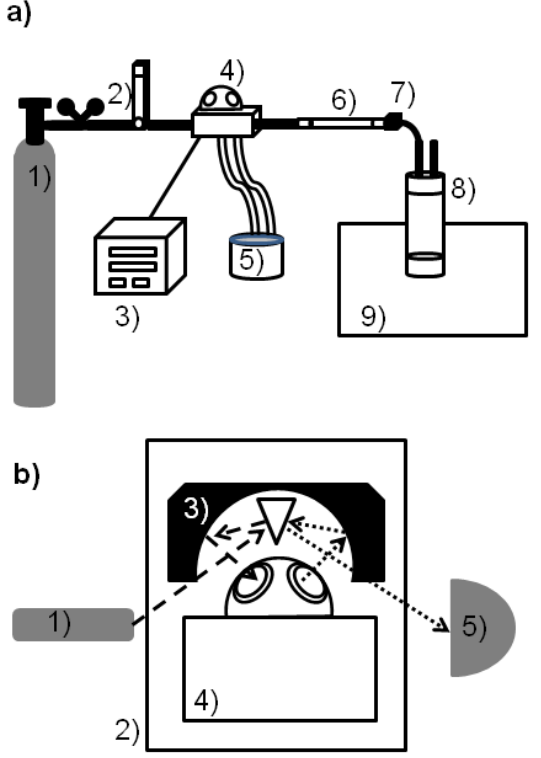
Fig. 1. Schematic of experimental setups. (a) FTIR-EGA system: (1) synthetic air purge/carrier gas, (2) pressure regulator and flow gauge, (3) automatic temperature controller, (4) high temperature reaction chamber with potassium bromide (KBr) windows and in- tegrated sample cup, (5) recirculating cooling water, (6) glass tube with magnesium perchlorate (Mg(ClO 4 ) 2 ) water trap, (7) sintered metal particulate trap, (8) variable path length gas cell, (9) FTIR spectrometer). (b) In situ T DRIFTS system: (1) infrared source, (2) diffuse reflectance chamber, (3) globular mirror, (4) high tempera- ture reaction chamber with potassium bromide (KBr) windows and integrated sample cup, (5) detector. Dashed lines indicate source in- frared beam; dotted lines indicate diffusely reflected infrared